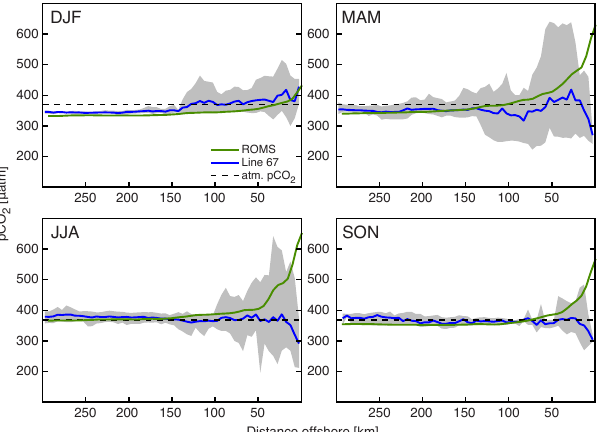
Fig. 4. Seasonally averaged p CO 2 from our model (green line) and from MBARI/CalCOFI Line 67 (blue line) as a function of dis- tance offshore. The gray shaded area represents the range of ob- served p CO 2 within each season. The dashed black line indicates our model’s annual mean atmospheric p CO 2 of 370µatm.